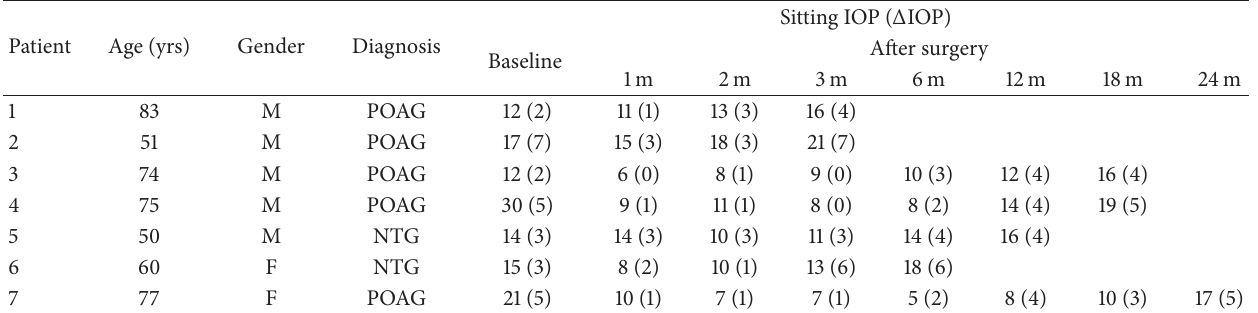
Table 2: Individual data for sitting and postural IOP changes.